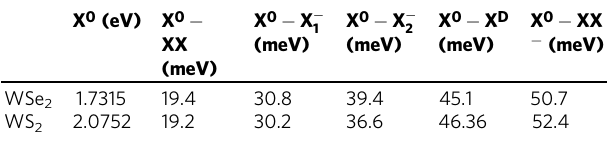
Table 1 Energy of the different exciton complexes with respect to the bright exciton X 0 appearing in the EL